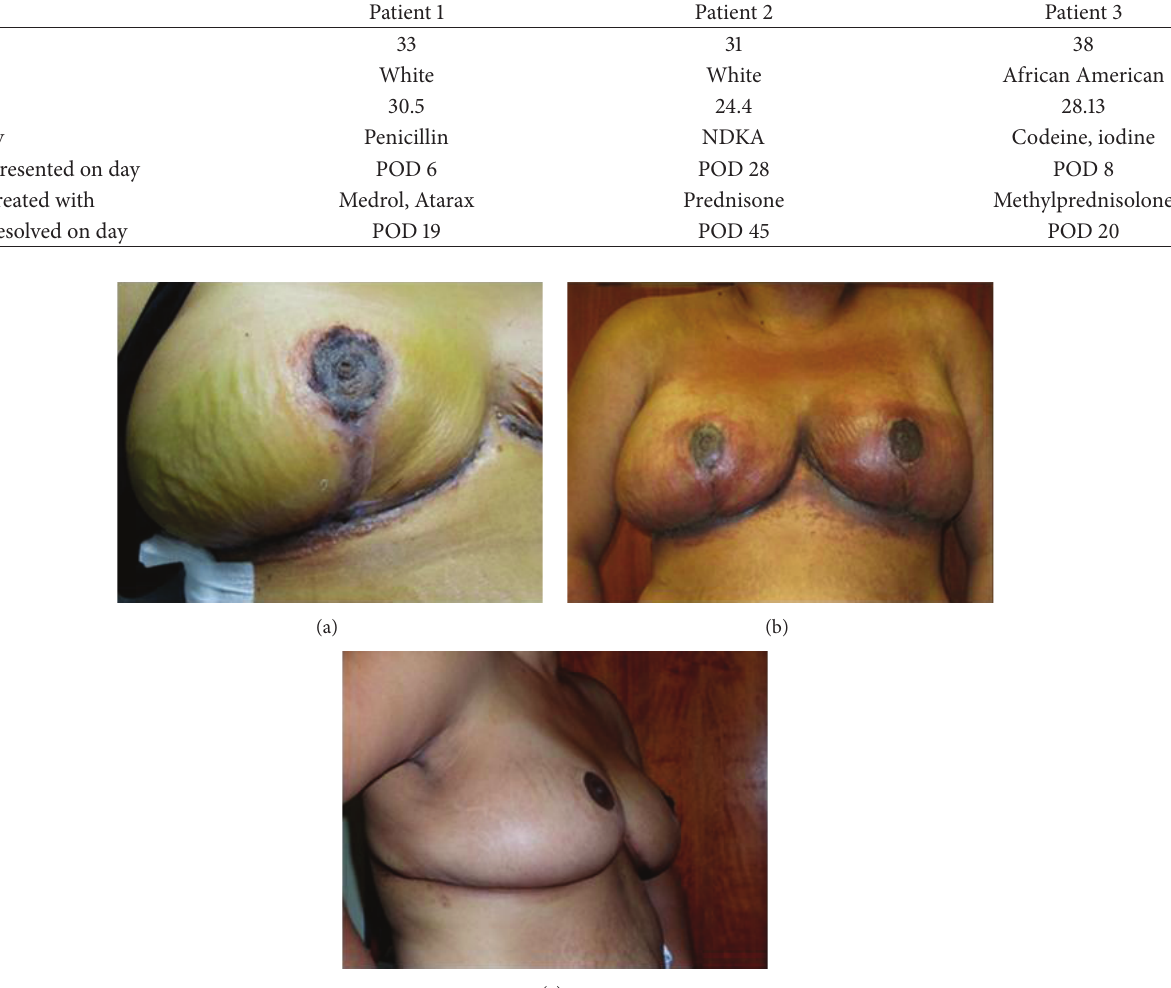
Figure 1: Progression of rash in patient. (a) Patient at initial follow-up postoperation day (POD) 6 with bilateral swelling, blisters, and erythema. (b) Patient at POD 11 after 5 days of steroid taper. Steroid taper was subsequently terminated due to gastrointestinal intolerance. Rash had spread bilaterally since initial presentation. (c) Resolution of rash at POD